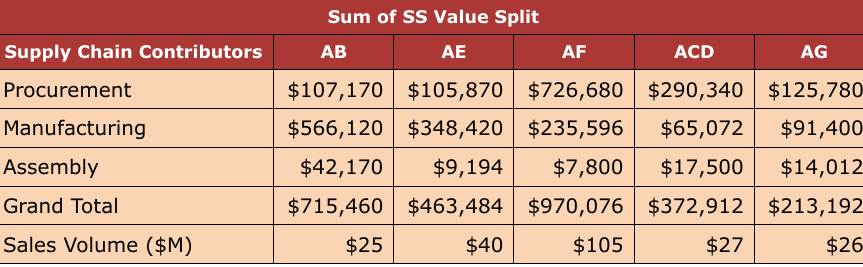
Table 5. Case company's safety stock distribution pivot